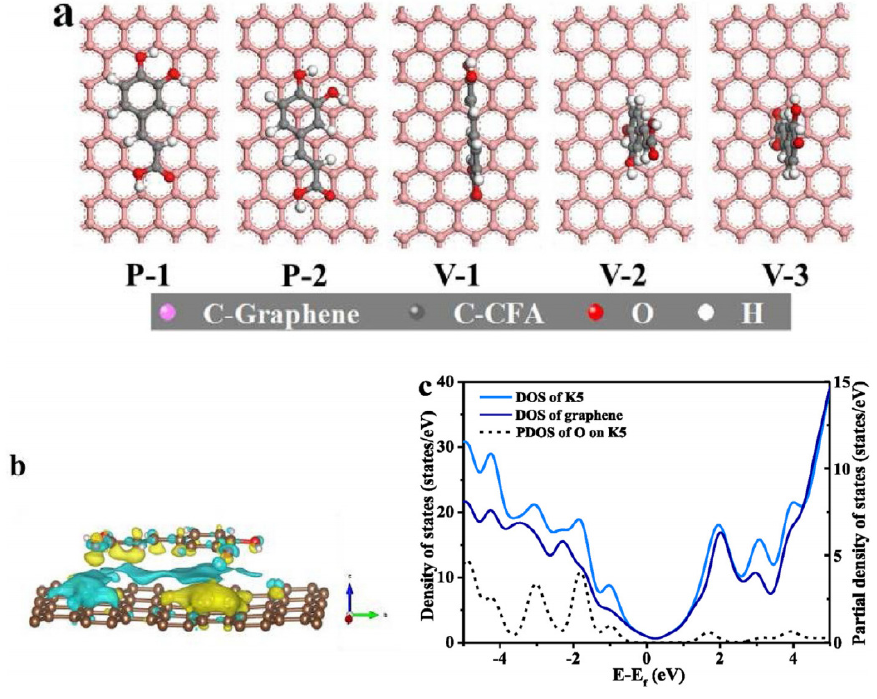
Figure 11. ( a ) DFT-optimized orientations of CFA on the graphene surface; ( b ) charge density for GH-CFA in stacked sites. ( c ) TDOS of pristine graphene and GH-CFA; PDOS for O of the hydroxyl group on GH-CFA. Reprinted from [25]. Copyright (2019), with permission from Elsevier.